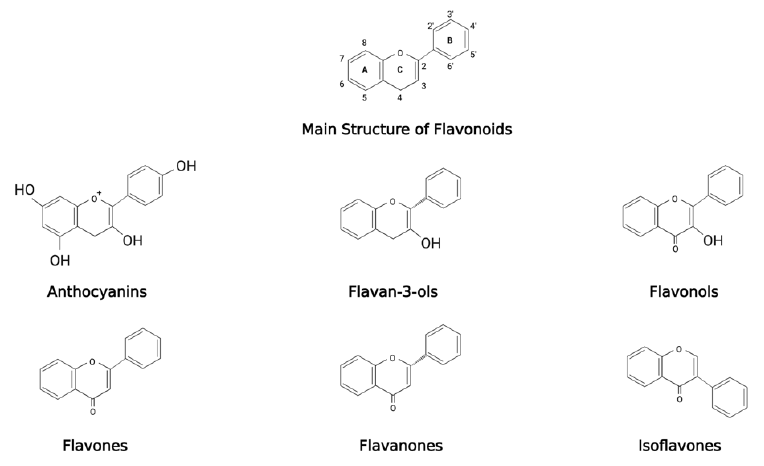
Figure 2. Chemical structure of flavonoid polyphenols. Created with BioRender.com. The flavonoid subclass of polyphenols is further classified into six main groups: anthocyanins, flavan-3-ols, flavonols, flavone, flavanones and isoflavones. Differences in chemical structure arise based on variations in the placement and number of hydroxyl groups and unsaturated